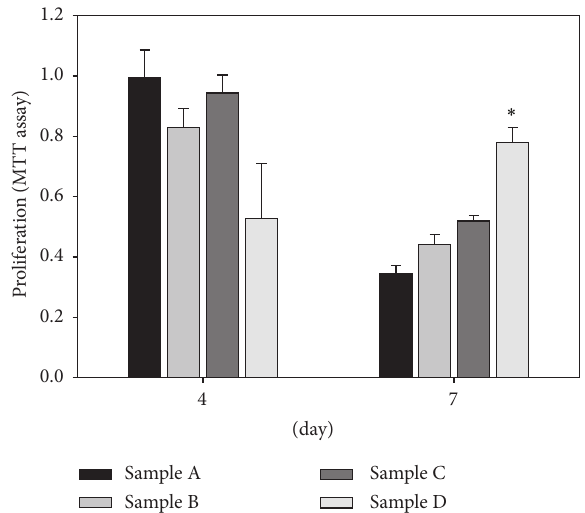
Figure 1: The pH values of the distilled water over the time (in weeks) with sample A (silica aerogel to PCL wt/wt ratio 0 :1), sample B (silica aerogel to PCL 0.125 :1), sample C (silica aerogel to PCL 0.25 :1), and sample D (silica aerogel to PCL 0.5 :1). ∗ 𝑃 < 0.05 .